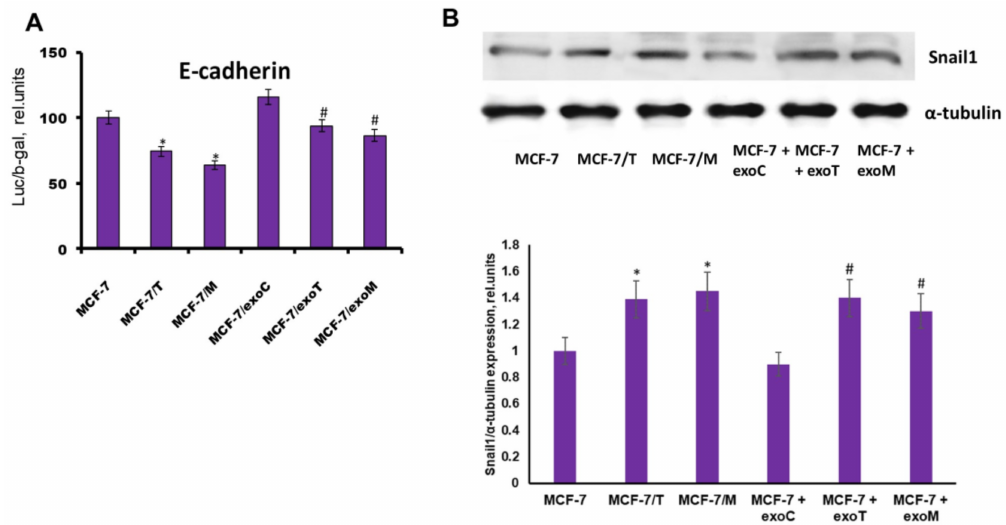
Figure 9. Expression and transcriptional activity of Snail1. The cell lines were similar to that in Figure 5. ( A ) Transcriptional activity of Snail1 was determined by reporter assay. The reporter assay was based on the Snail1 ability to inhibit the expression of the transfected luciferase reporter gene contained Snail-responsive elements from E-cadherin promoter (E-cad/Luc). The transfection efficiency was controlled by co-transfection of the cells with plasmid containing the β -galactosidase gene, luciferase activity was determined as described in the Methods section. Data represent mean value ± S.D. of three independent experiments. * p < 0.05 versus MCF-7, # p < 0.05 versus MCF-7/exoC. ( B ) Western blot analysis of Snail1 in total cell extracts. Protein loading was controlled by membrane hybridization with α -tubulin Abs. Densitometry was performed using ImageJ (NIH) software. Densitometry data represent mean value ± S.D. of three independent experiments. * p < 0.05 versus MCF-7, # p < 0.05 versus MCF-7 +